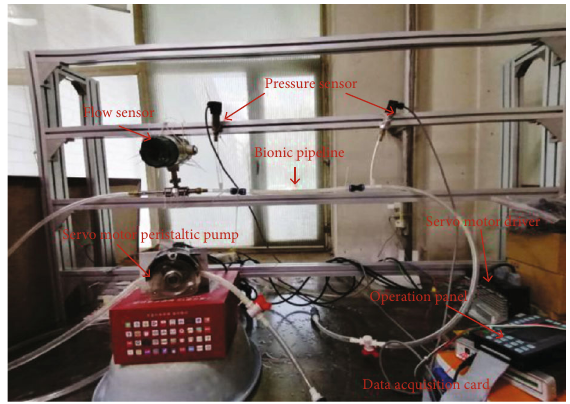
Figure 10: Experimental